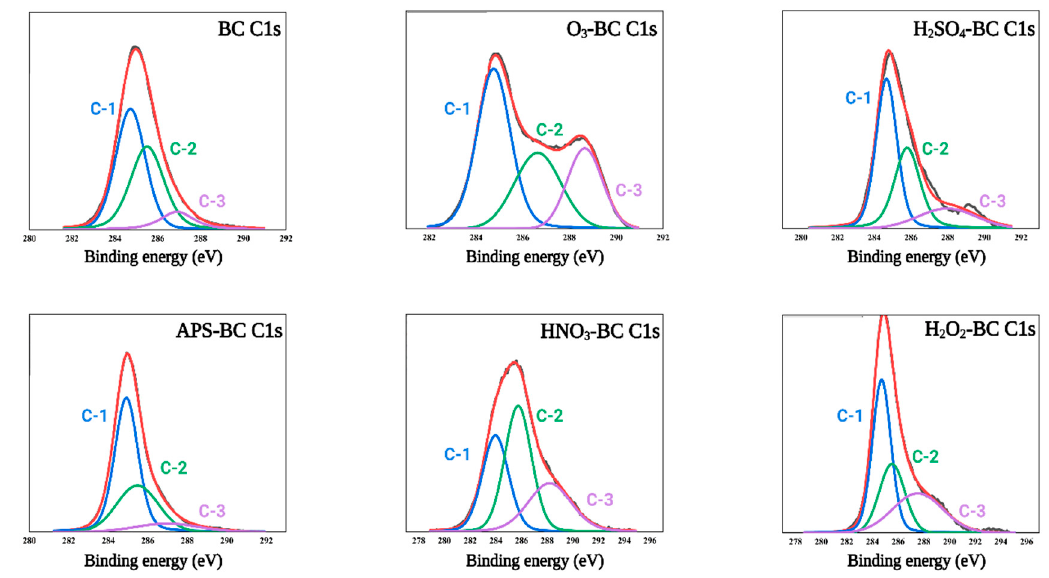
Table 4. Atomic composition of pristine and oxygen-enriched biochar samples.